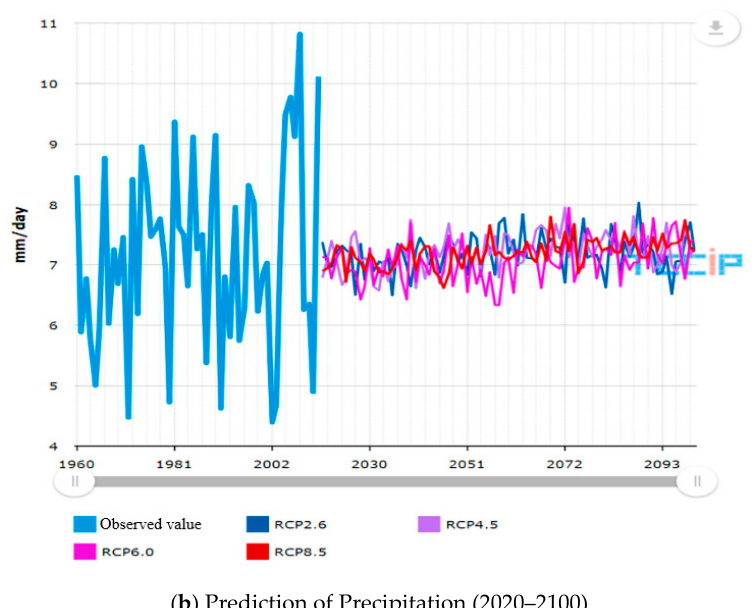
Figure 2. Future temperature and precipitation predictions of four scenarios for Huisun Forest.